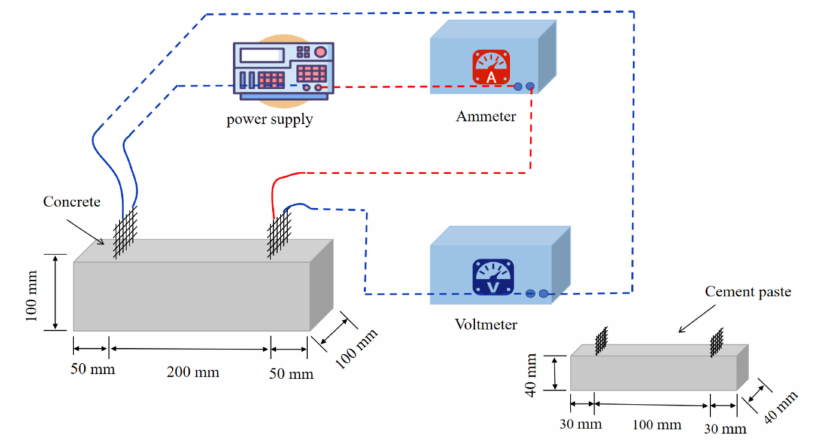
Figure 1. Measurement of electrical